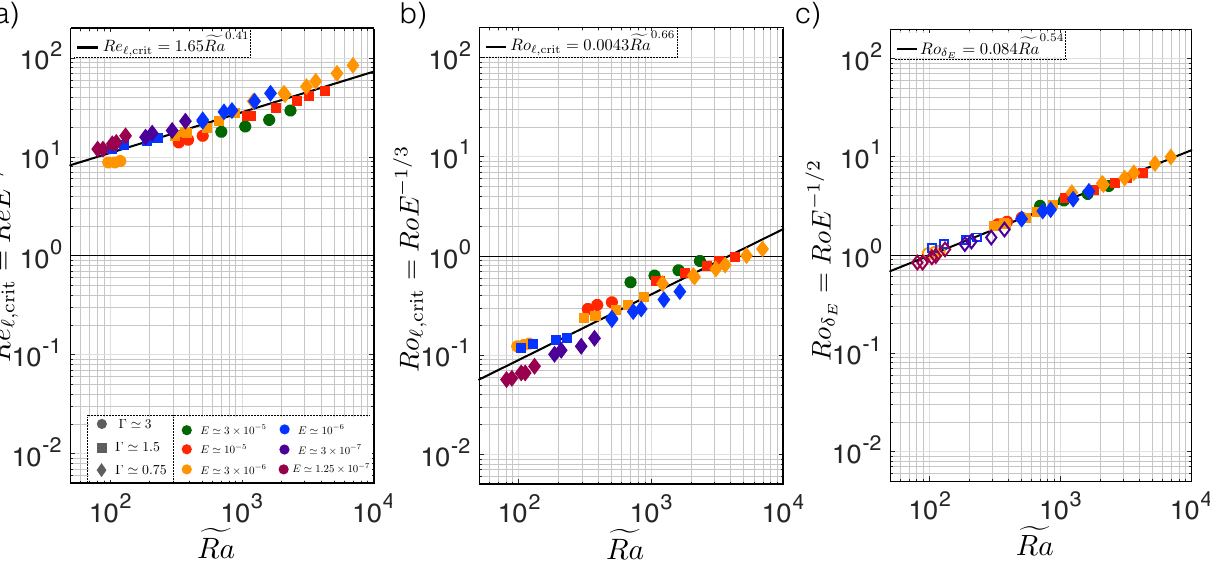
Ra = RaE 4/3 . The colors and symbols are ( 10 1 10 2 ) . ( b ) Ro (cid:96) ,crit = RoE − 1/3 vs. O − (cid:102) = RoE − 1/2 vs. Ra . E 1, whereas the T ≤ (cid:102) > 1. The estimated local Ro values within the boundary T